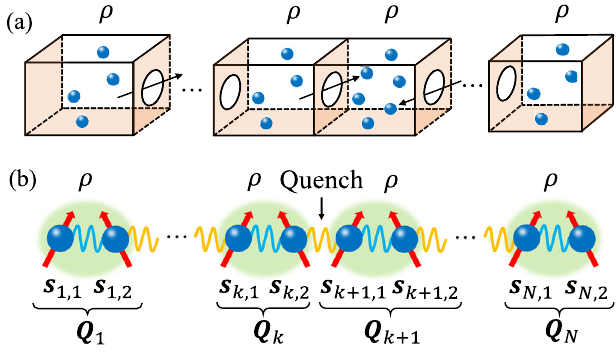
FIG. 3. Toy examples of multiple copies of the system under global symmetry constraints. (a) U(1) symmetry and the particle number conservation. The total particle number should be conserved, while individual copies can exchange particles with each other. (b) SU(2) symmetry and the spin conservation. Each copy of the system is represented by a “ dimer ” consisting of two spin- 1 = 2 systems. We consider the situation where the total spin is conserved in all the spatial directions, while each spin is not necessarily conserved. Such symmetry-respecting interaction between the dimers can be induced, for example, by quenching the second term on the Hamiltonian Eq.